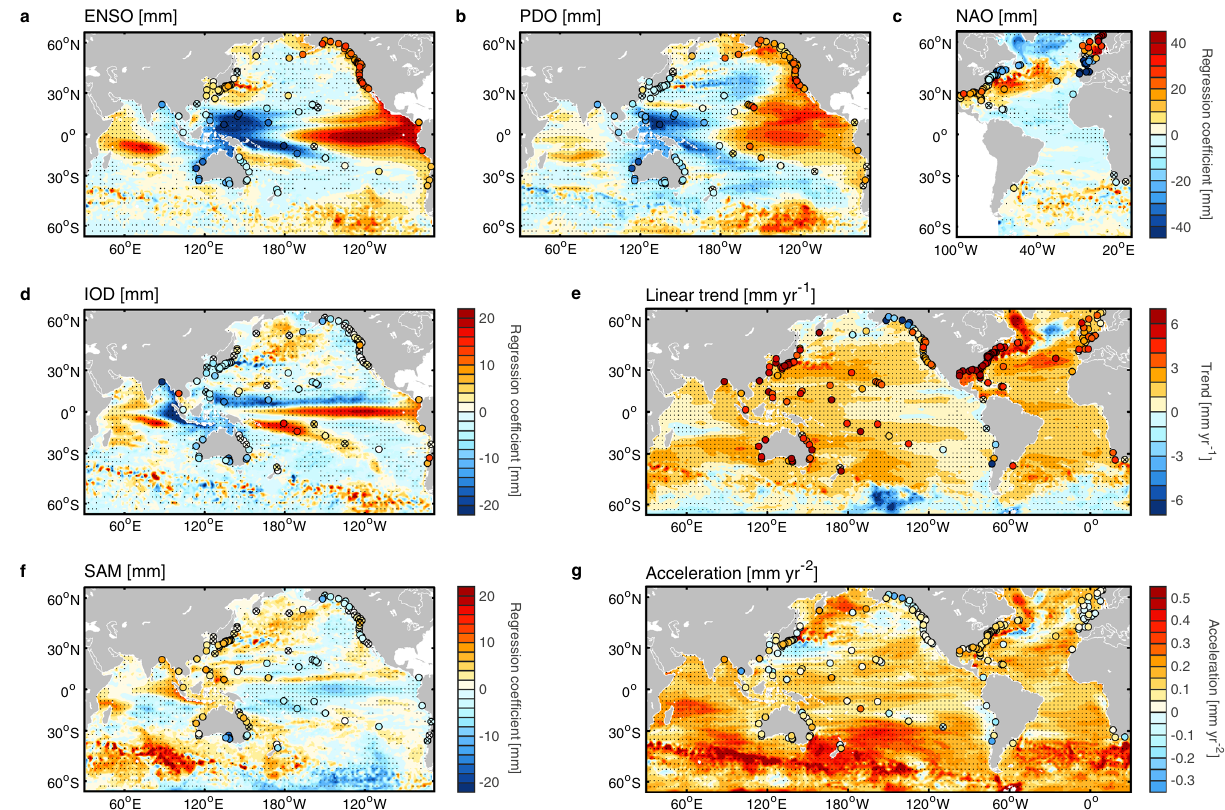
Fig. 3 Regression coef fi cient maps from the multiple variable linear regression (MVLR) analysis. Colored circles indicate signi fi cant regression coef fi cients (90% con fi dence level) of tide-gauge data (1970 – 2018) related to a the El Niño — Southern Oscillation (ENSO), b the Paci fi c Decadal Oscillation (PDO), c the North Atlantic Oscillation (NAO) (all with the same colour scale), d the Indian Ocean Dipole (IOD), e linear trend, f the Southern Annular Mode (SAM), and g acceleration (twice the quadratic term). Regression coef fi cients of tide-gauge records, which are not signi fi cant at 90% con fi dence level are denoted as cross symbols (hereafter). The corresponding coef fi cient contours are based on the Ocean Reanalysis System 5 (ORAS5) ocean-reanalysis over the same period. Stippling indicates where the coef fi cients are statistically signi fi cant at the 90% con fi dence level for ORAS5 reanalysis.